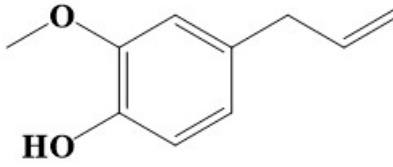
Figure 1. Chemical structure of eugenol.